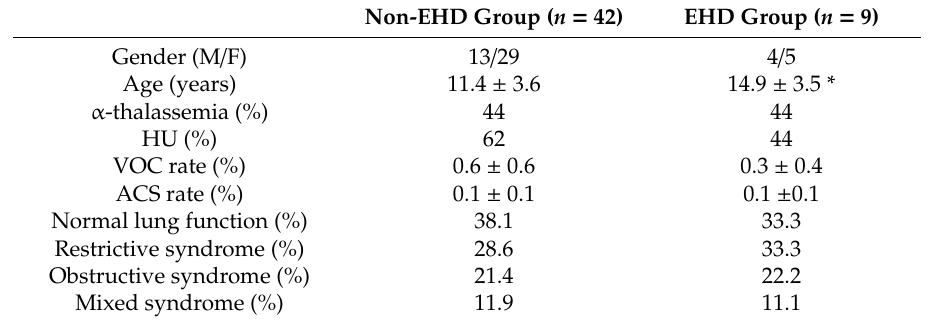
Table 2. Clinical characteristics of the patients according to exercise-related hemoglobin